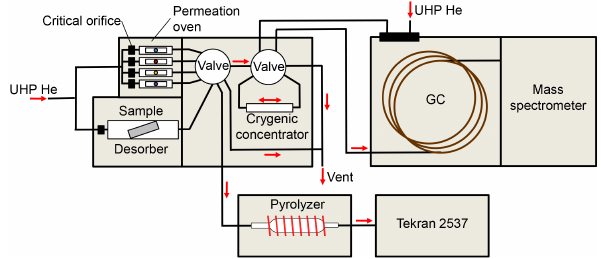
Figure 1. Diagram of GC/MS system used to identify Hg com- pounds, and a pyrolyzer and Tekran 2537 system to quantify the amount of Hg compounds generated by the permeation